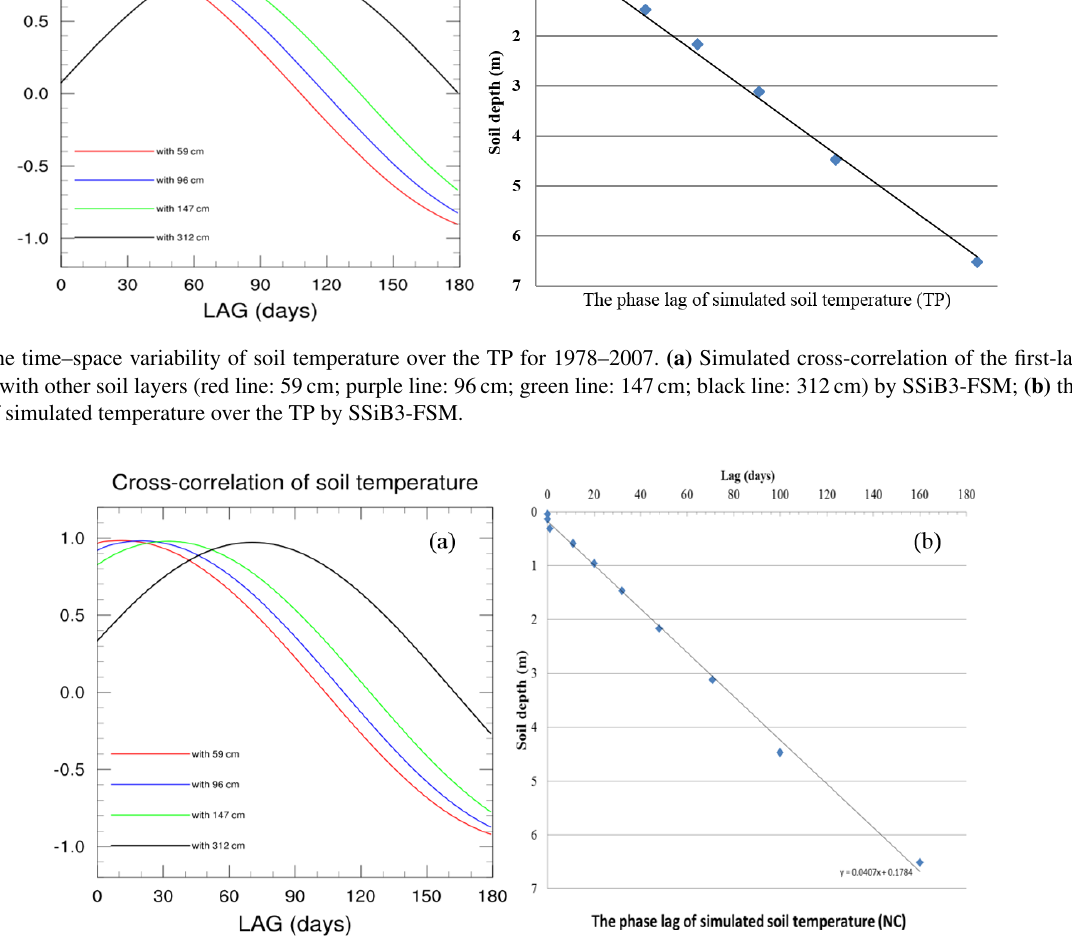
Figure 8. The time–space variability of soil temperature over NC for 1978–2007. (a) Simulated cross-correlation of the first-layer soil temperature with other soil layers (red line: 59cm; purple line: 96cm; green line: 147cm; black line: 312cm) by SSiB3-FSM; (b) the phase lag (days) of simulated temperature over NC by SSiB3-FSM.